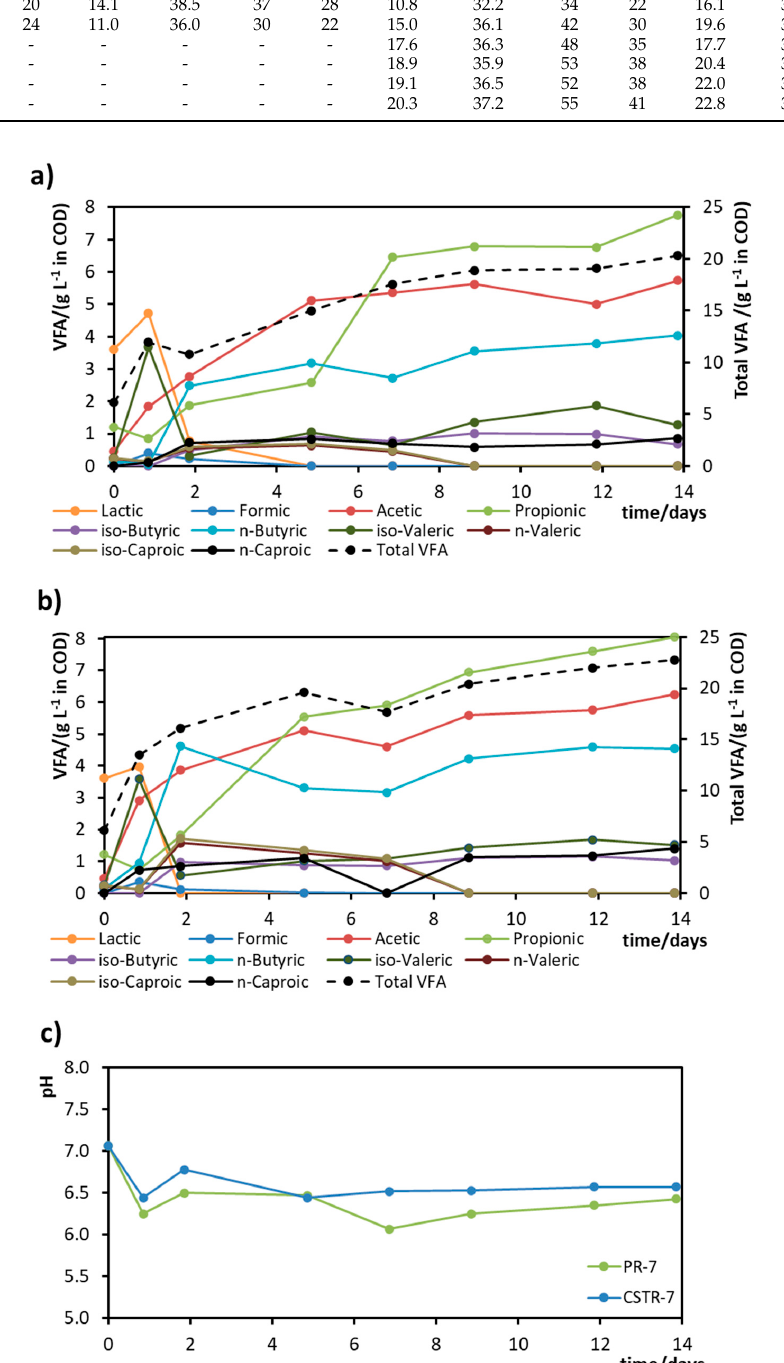
Figure 3. VFA and lactic acid profiles in reactors PBSR-7 ( a ) and BSR-7 ( b ), over time. ( c ) Time course of pH in reactors PBSR-7and BSR-7.